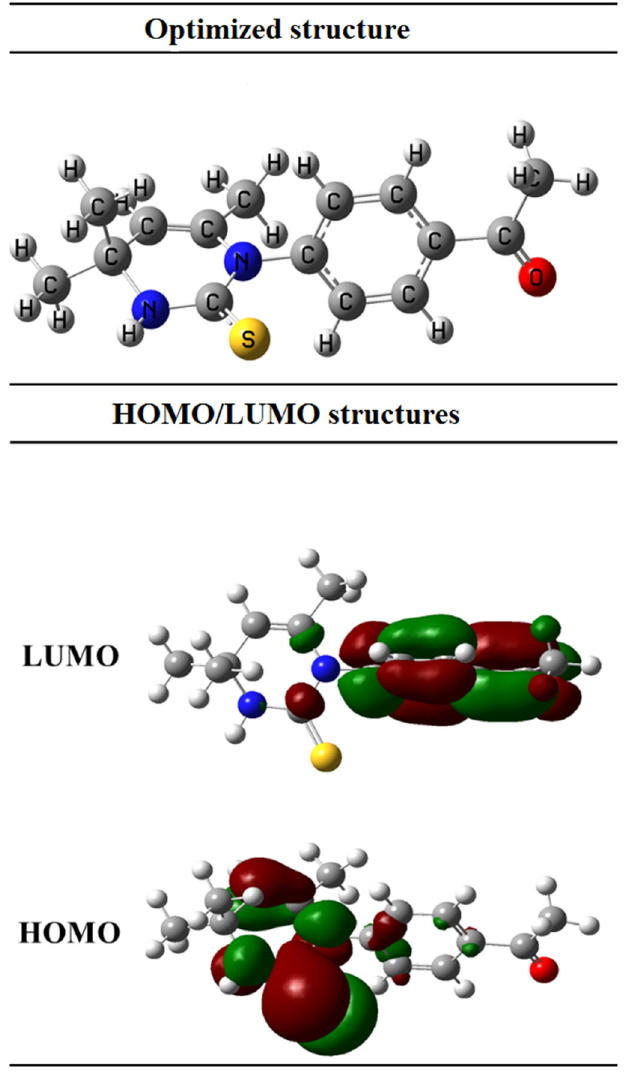
Figure 7. Optimized and HOMO-LUMO structures of compound 4 .